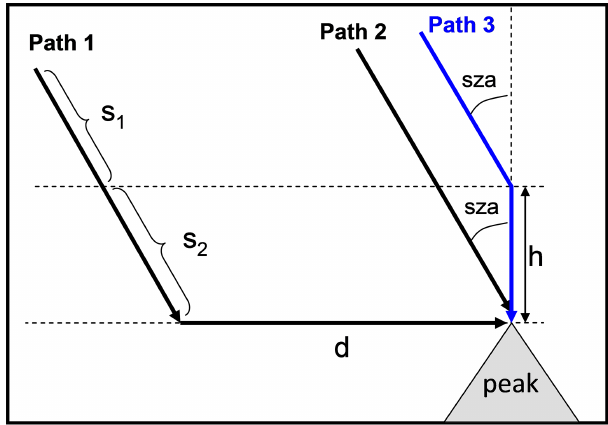
Figure 1. Schematic representation of a simplified optical path of scattered solar radiation for real (blue) and MGA-approximated (black)